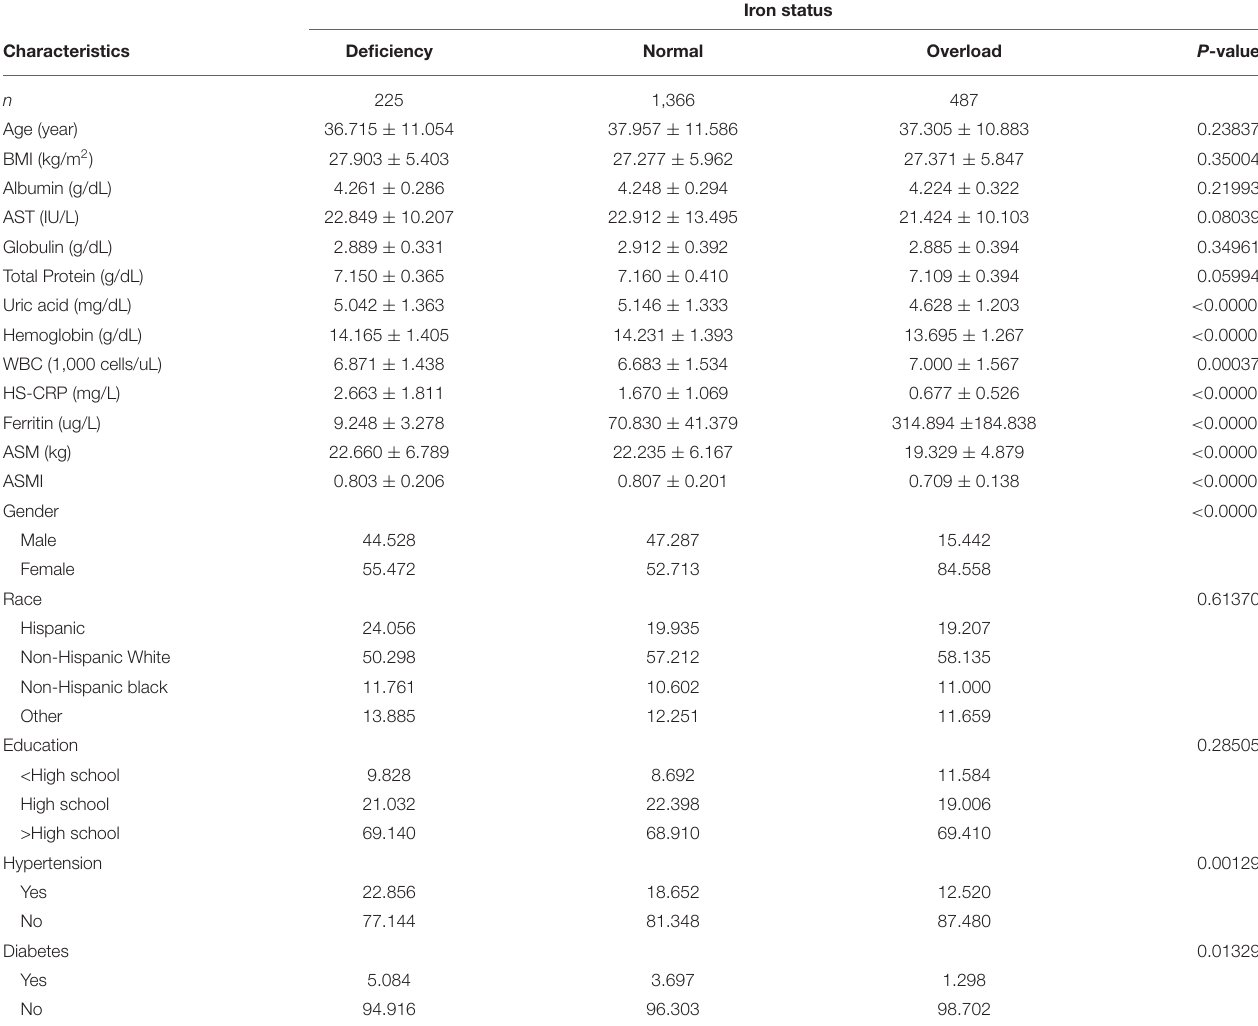
TABLE 1 | Baseline characteristics of study participants.